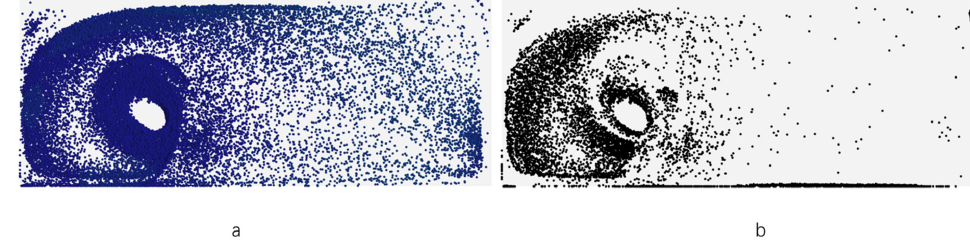
Figure 28. Location and collision of particles in b10: ( a ) Location of particles; ( b ) Collision of particles.